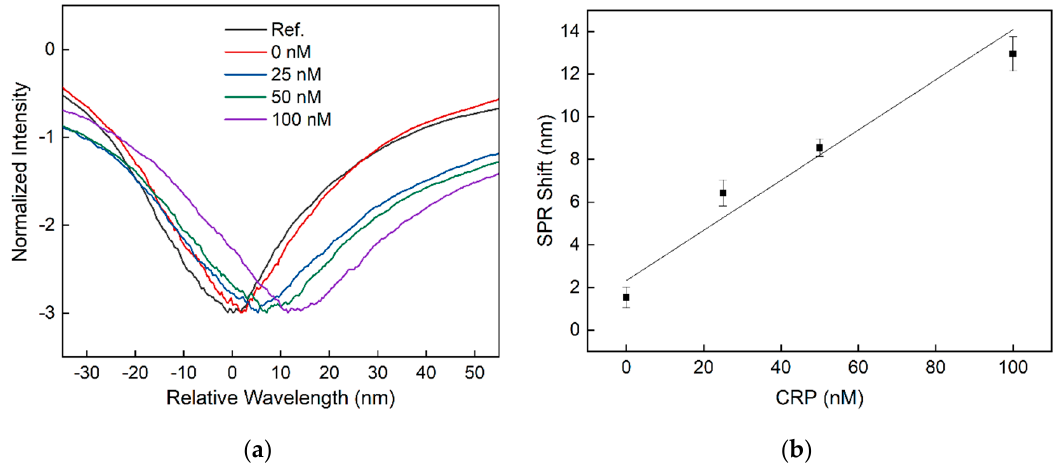
Figure 4. Transmission spectra ( a ) and SPR wavelength shift ( b ) for different CRP concentrations in combination with the applied AuNP sandwich assay.